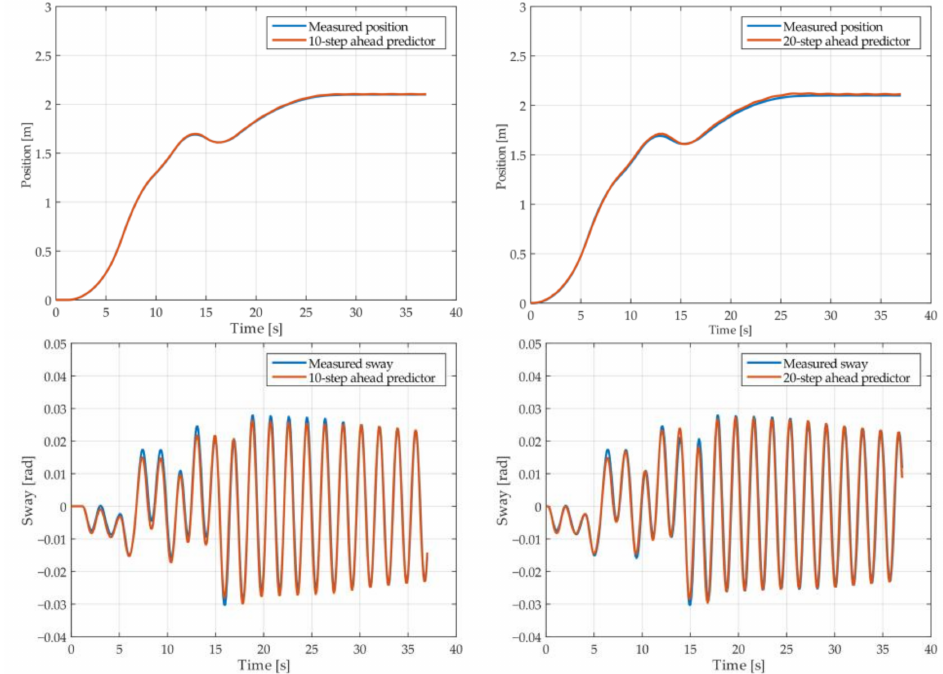
Figure 5. The 10- and 20-step ahead prediction with the MGGP model of the simulated crane position and payload sway with 0.9 m rope length and 10 kg payload mass.